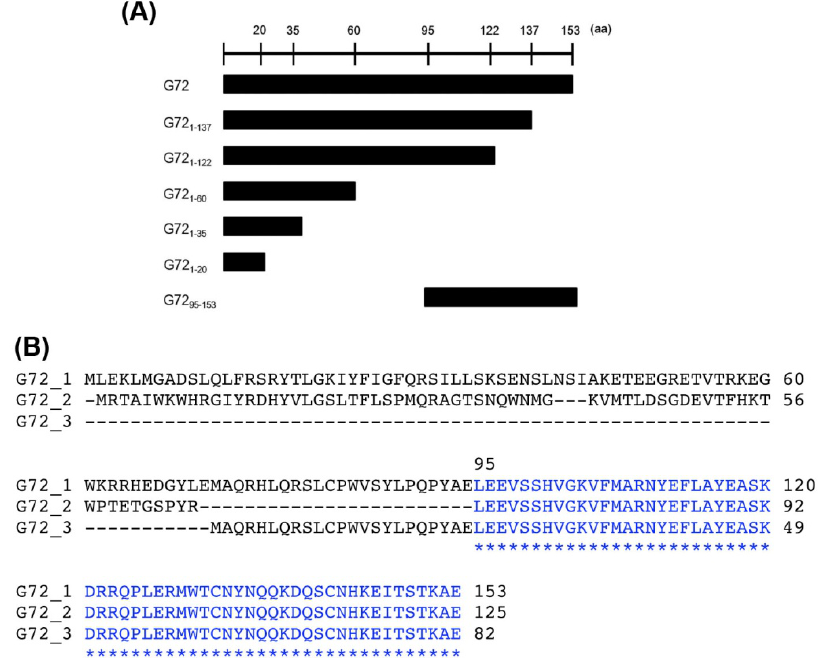
Figure 2. Truncated fragments of G72. ( A ) Schematics of the G72 constructs co-transfected with activation domain (AD)-DAO in yeast; and ( B ) The amino acid sequence alignment of the three G72 isoforms. The residues of the C -terminal sequence that are identical in the isoforms are shown in blue.